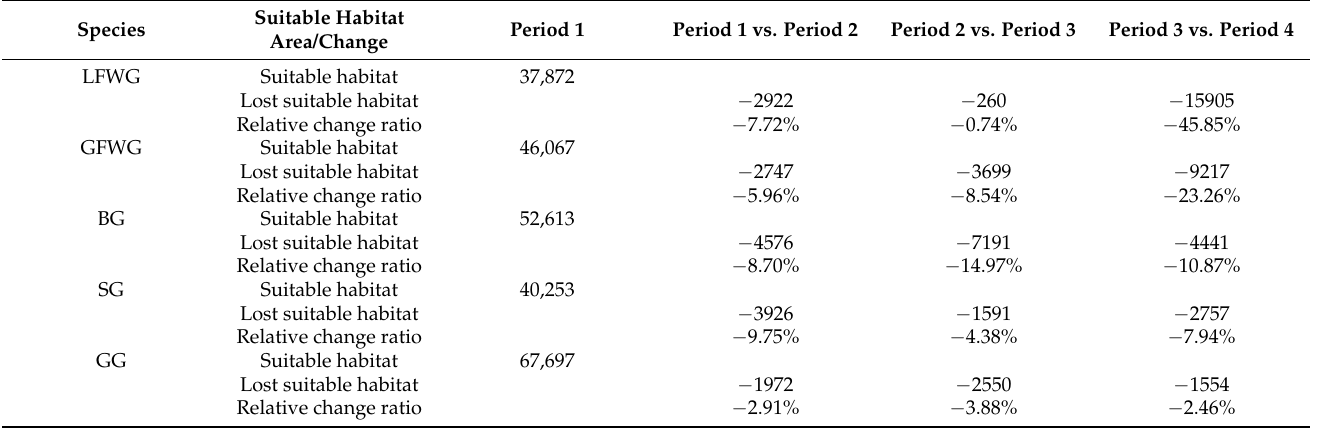
Table 3. The suitable habitat area (km 2 ) loss and the relative change ratio (%) of suitable habitat between two consecutive periods. Lesser white-fronted goose (LWFG); greater white-fronted goose (GWFG); bean goose (BG); swan goose (SG); and greylag goose